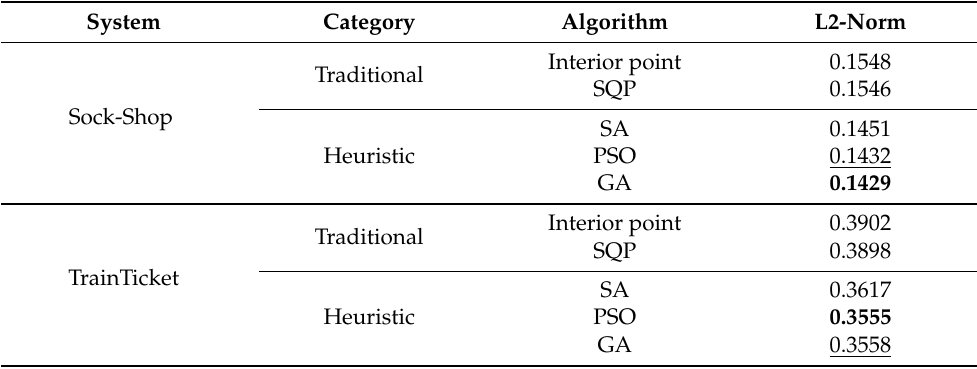
Table 14. Optimization effects of different algorithms. The best results are in bold, and the second best ones are underlined. The hyperparameters in the heuristic algorithm are set to empirical values that work well.